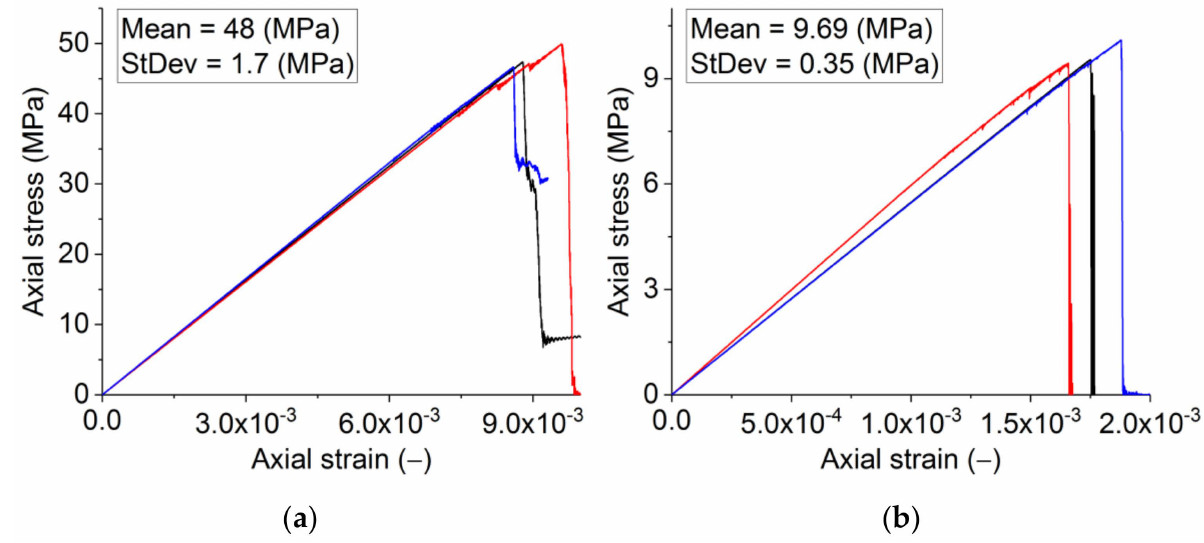
Figure 4. Numerically obtained uniaxial compression ( a ) and tension ( b ) diagrams with the use of the final strength parameters for mesoscopic structural elements. Diagrams are shown for the three statistically equivalent